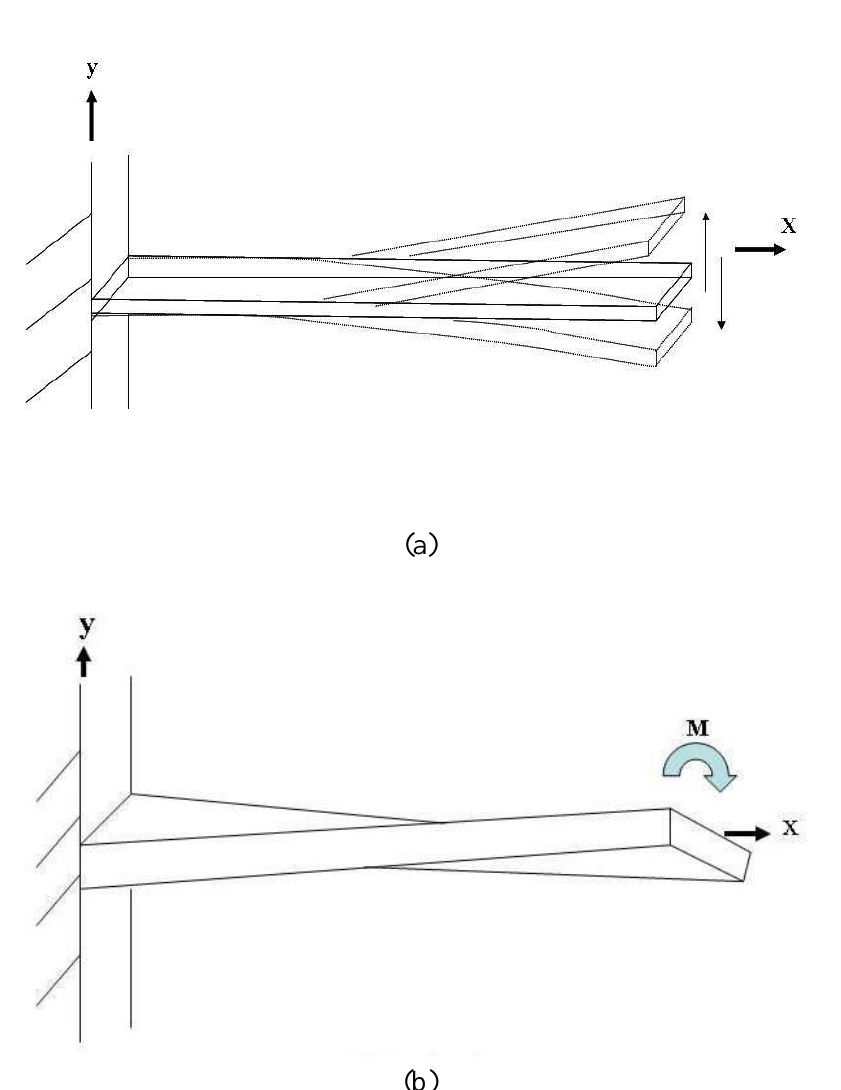
Figure 12. (a) Bending mode and (b) torsional mode of a cantilever